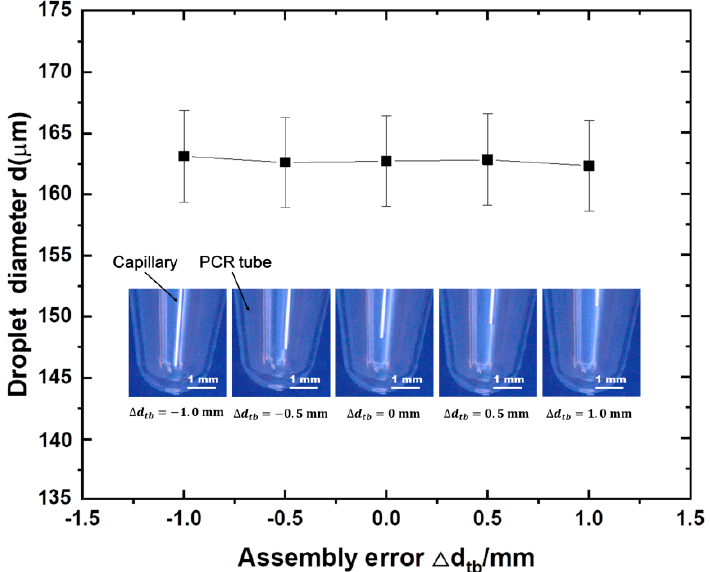
Figure 3. Experiments with different assembly errors. Experiments were carried out when centrifugal acceleration was held constant (108 g). Each data point corresponds to three independent measurements of droplet diameter. Error bars given are standard deviations (SDs).